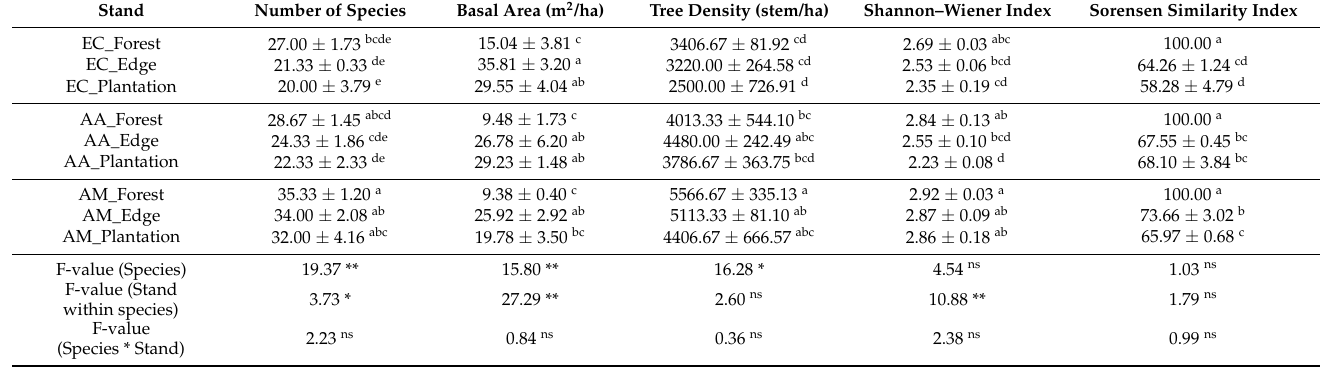
Table 1. Structure and diversity in nine stands of three exotic plantations. EC: Eucalyptus camaldulensis ,